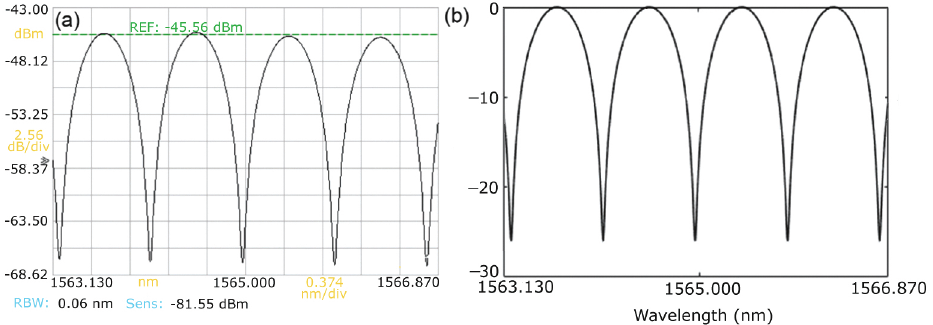
Figure 4. BFL response: ( a ) experimental, ( b )